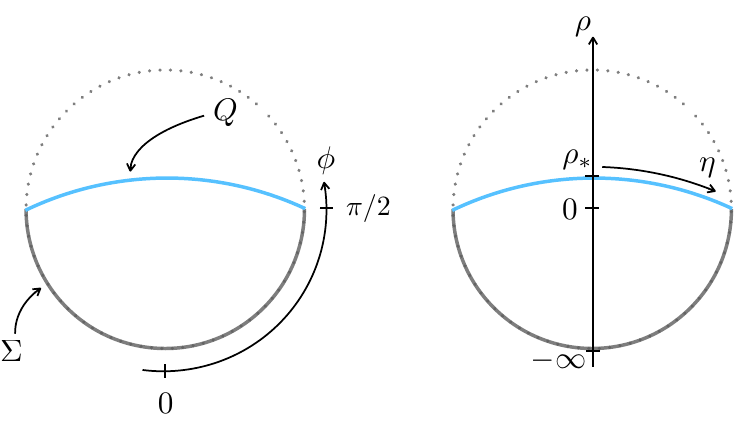
Figure 3 . A time slice τ = const . of the vacuum configuration in the ( τ, r, φ ) coordinate (left) and the ( τ, η, ρ ) coordinate (right) respectively. The asymptotic boundary Σ is shown in grey and the end-of-the-world brane Q is shown in blue. The dotted curve shows the asymptotic boundary of global AdS . The bulk region M is surrounded by M = Σ ∪ Q . Here, tension T is positive in this 3 figure so that the larger portion of pure AdS is identified as the bulk M 3